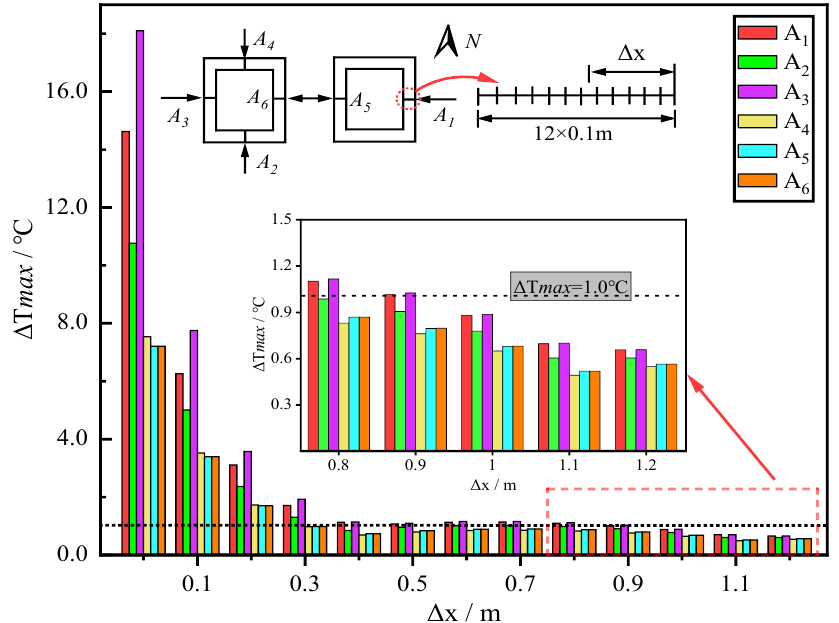
Figure 25. The maximum variation of temperature at the same distance from the external surface of the tower wall at a height of 125 m.